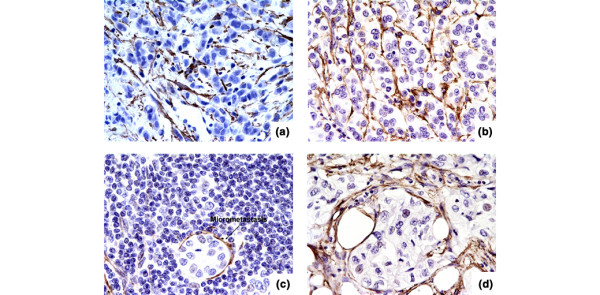
Immunohistochemical staining for α-smooth muscle actin in metastases of human breast cancer to (a) bone marrow, (b) liver, (c) lymph node, and (d) pleura. In all of the cases that we examined, there was extensive infiltration of the tumor metastases by myofibroblasts (brown stain). Note that the myofibroblasts appeared to be in direct contact with nearly all of the tumor cells in these sections. Even very early micrometastases (defined as fewer than 100 tumor cells) of well differentiated tumors to lymph nodes (panel c) and larger metastases of poorly differentiated tumors (panel d) were in very close proximity to myofibroblasts. Serial sections of the same tissues did not stain for CD10 or smooth muscle myosin heavy chain (not shown), thereby confirming that the cells are myofibroblasts rather than myoepithelial cells. Hematoxylin counter-stain was used.